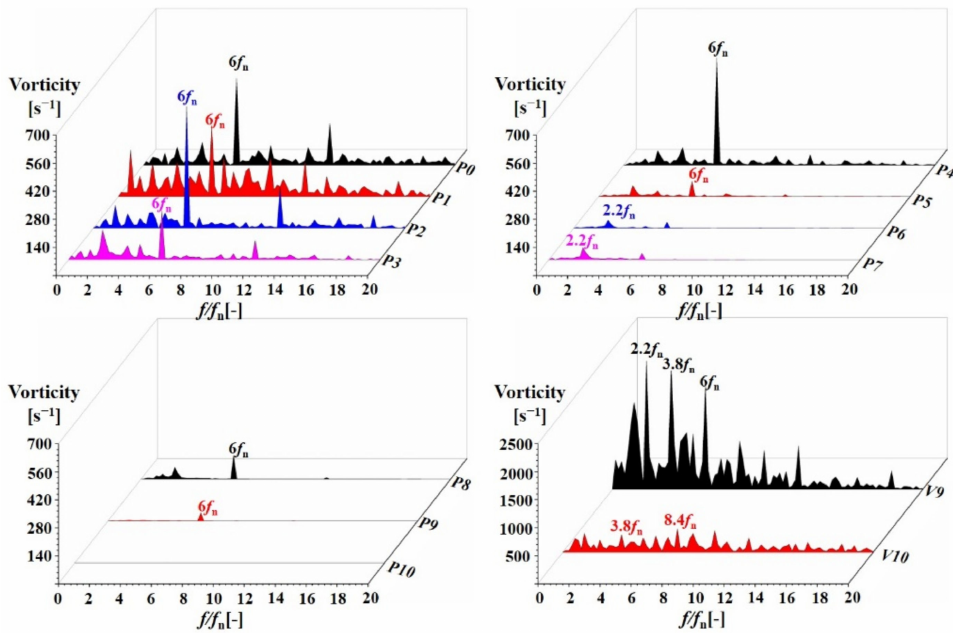
Figure 15. Frequency domain of vorticity fluctuation at the 1.3 Q b operation